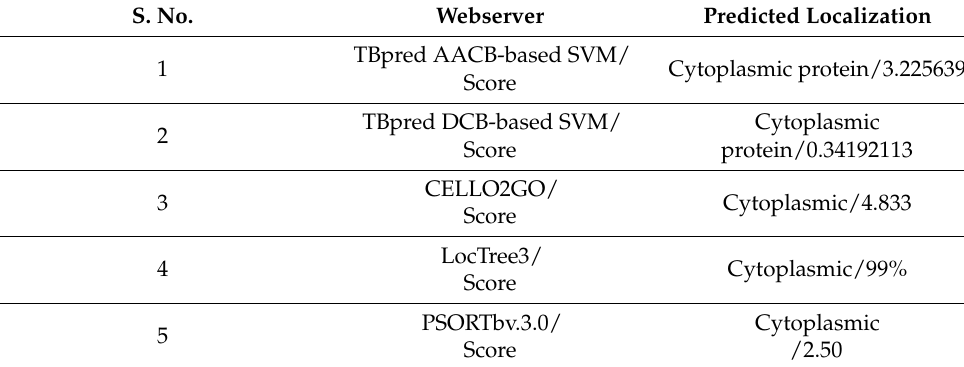
Table 2. Subcellular localization prediction of mycobacterial protein Rv1636